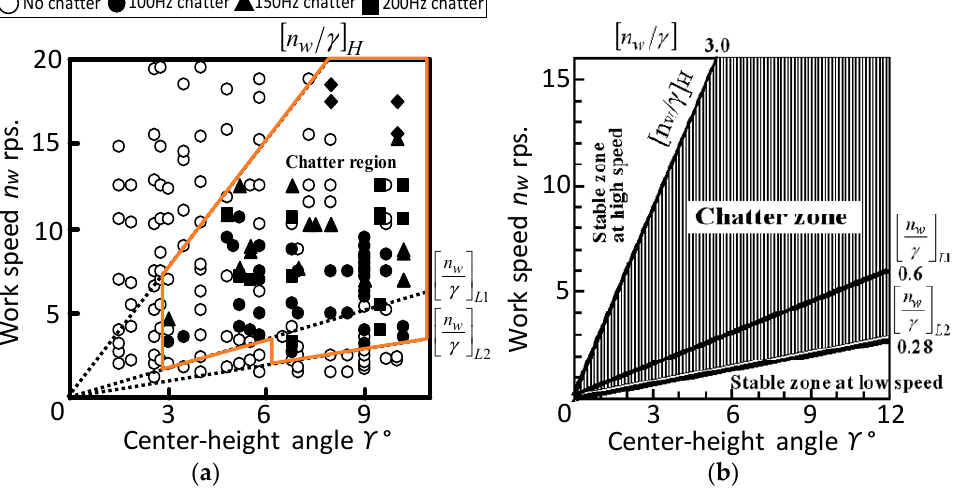
Figure 15. Dynamic system stability criterion for machine A. ( a ) Chatter zones confirmed by grinding tests; ( b ) Dynamic system stability criterion.